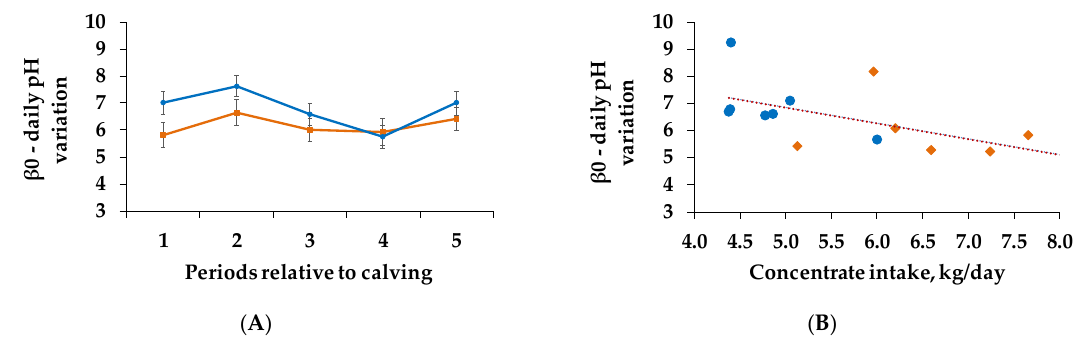
Figure 3. β 0 ( A : illustrates the slope of the regression line at the inflection point and therefore displays the variation of rumen pH over 24 h; the greater the values the more constant the ruminal pH) during period 1 (weeks 1–2 postpartum), period 2 (weeks 3–4 postpartum), period 3 (weeks 5–6 postpartum), period 4 (weeks 7–8 postpartum) and period 5 (weeks 9–10 postpartum) as well as regression of β 0 and